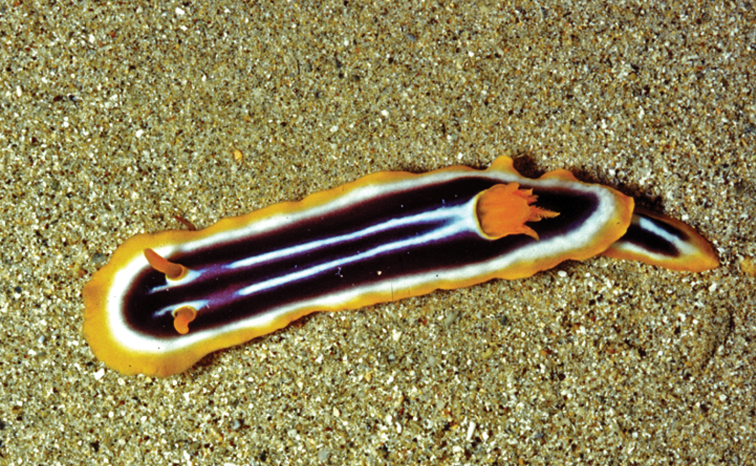
Chromodoris africana, Madagascar, photo: J Hinterkircher (no spcm).